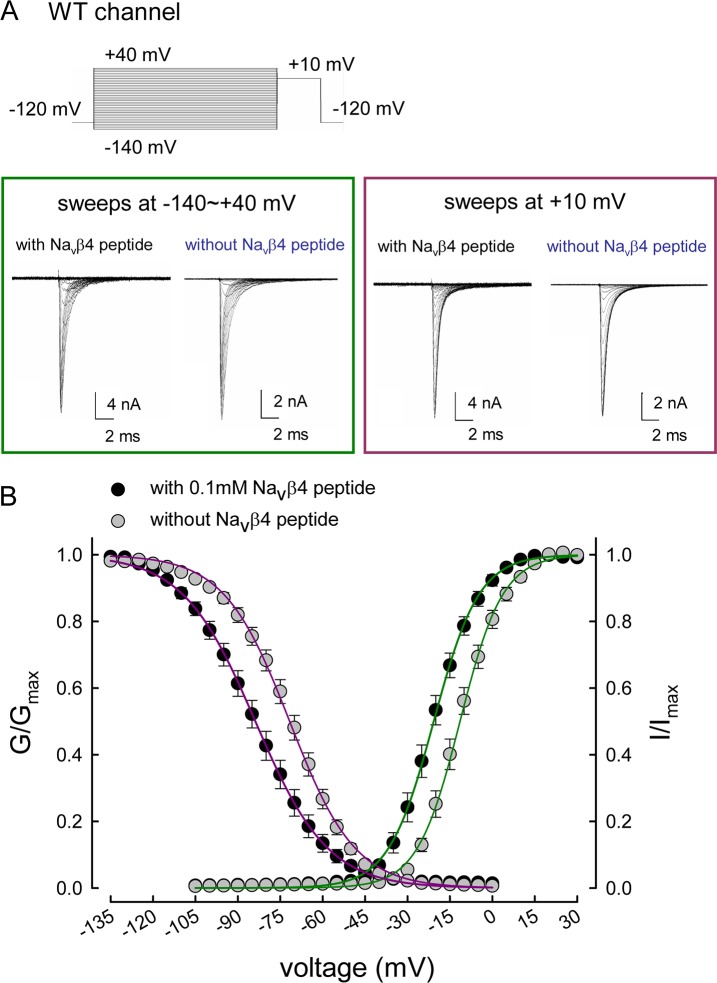
The activation and inactivation curves of the WT Nav1.7 channel in the presence and absence of the Navβ4 peptide.(A) Sample sweeps for the making of the activation (green box, on the left) and inactivation (purple box, on the right) curves in the presence and absence of the Navβ4 peptide are shown (see Materials and Methods for the experimental protocols). (B) The activation and inactivation curves for the each cell are fitted with Boltzmann functions, and the cumulative results for Vh are –20.74±1.47 mV and –11.19±1.21 mV with and without the Navβ4 peptide, respectively (n = 15; p < 0.05), and k are 7.11±0.33 and 6.90±0.41 with and without the Navβ4 peptide fort the inactivation curve, respectively (n = 15; no significant difference). For the inactivation curves, the Vh are –83.64±2.17 mV and –71.80±1.61 mV with and without the Navβ4 peptide, respectively (n = 15; p < 0.05), and k are –11.55±0.43 and –10.89±0.37 with and without the Navβ4 peptide, respectively (n = 15; no significant difference). Single Boltzmann functions fits to the mean values are for the activation curve, the Vh and k are ~–20.7 mV and ~8.0 with 0.1 mM Navβ4 peptide, and ~–11.43 mV and ~7.6 without the Navβ4 peptide, respectively; for the inactivation curves, the Vh and k are ~–83.8 mV and ~12.8 with 0.1 mM Navβ4 peptide and ~–71.7 mV and ~11.6 without the Navβ4 peptide, respectively. Individual data is shown in the file of S1 Data.